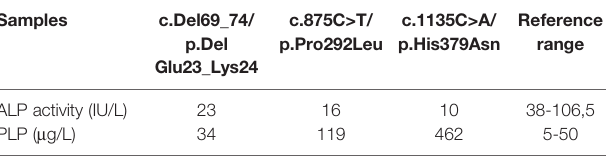
TABLE 1 | Biochemical determinations of ALP and PLP associated with mutations of uncertain signi fi cance.